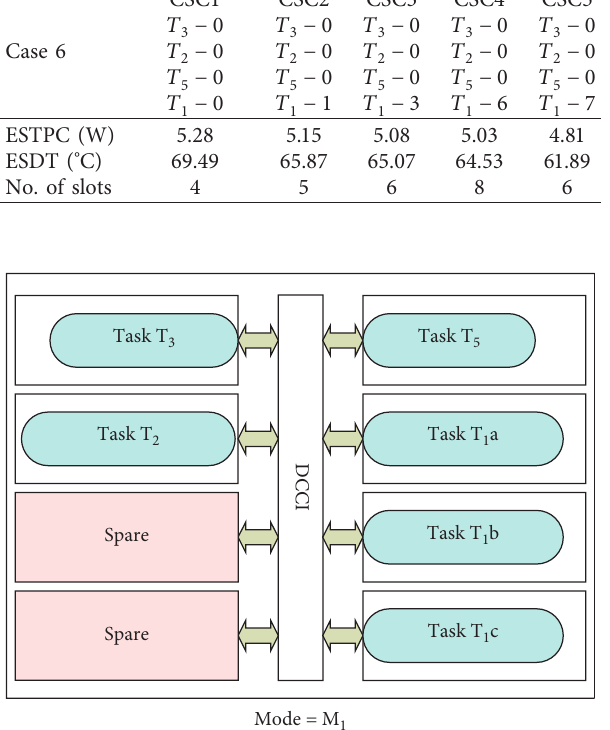
Figure 16: Selected system configuration for RTSA using Explorer for case 6.